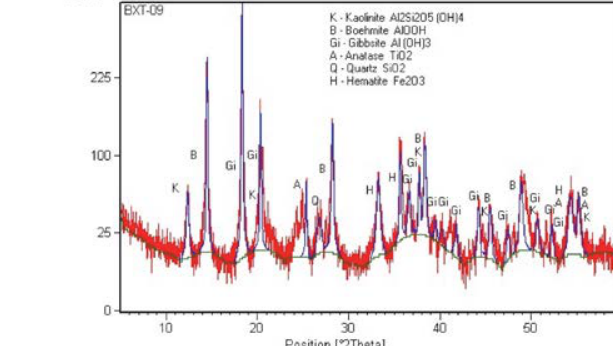
Figure 2. Diffractogram of the standard bauxite sample NBS 696 (Surinam)